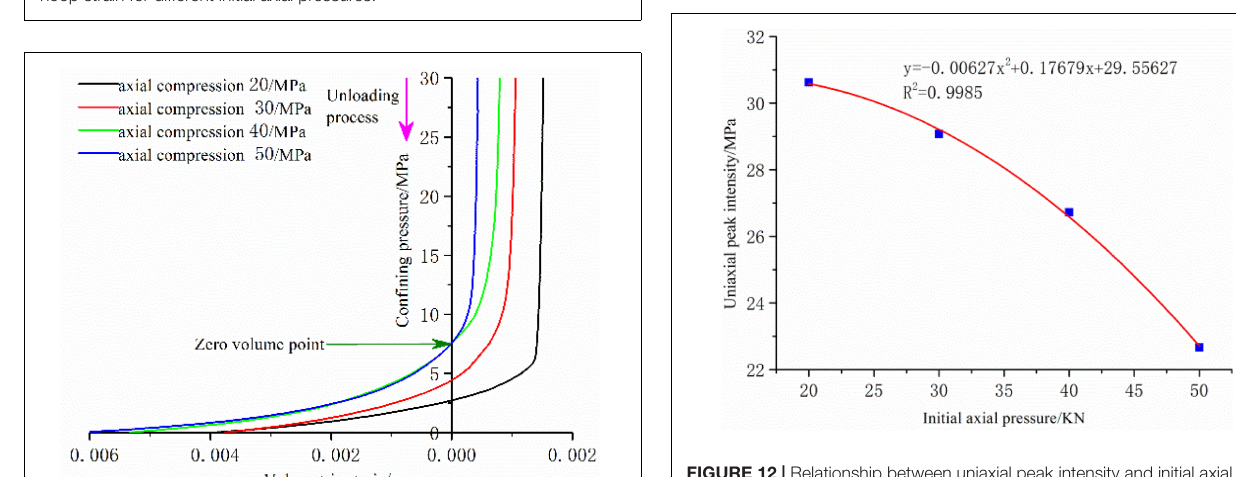
FIGURE 9 | Curves of confining pressure during the unloading process vs. hoop strain for different initial axial pressures.